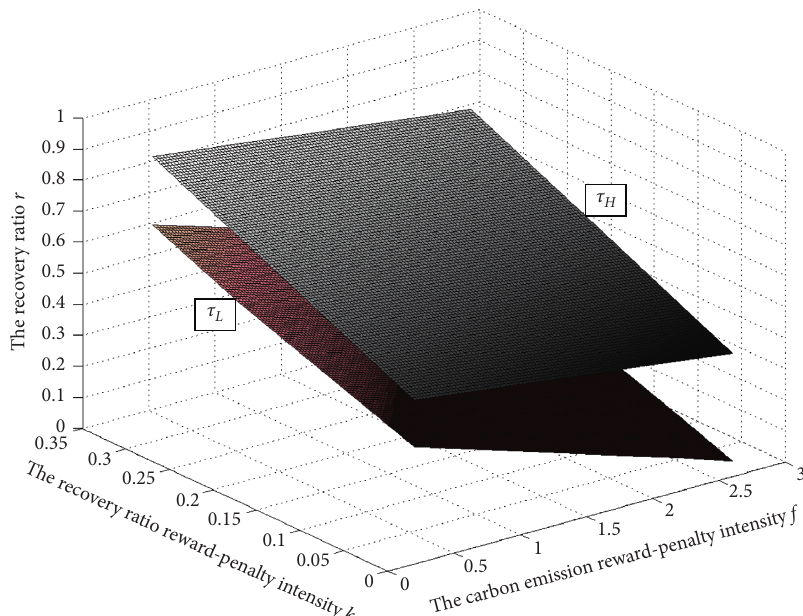
Figure 5: WEEE recovery rate τ